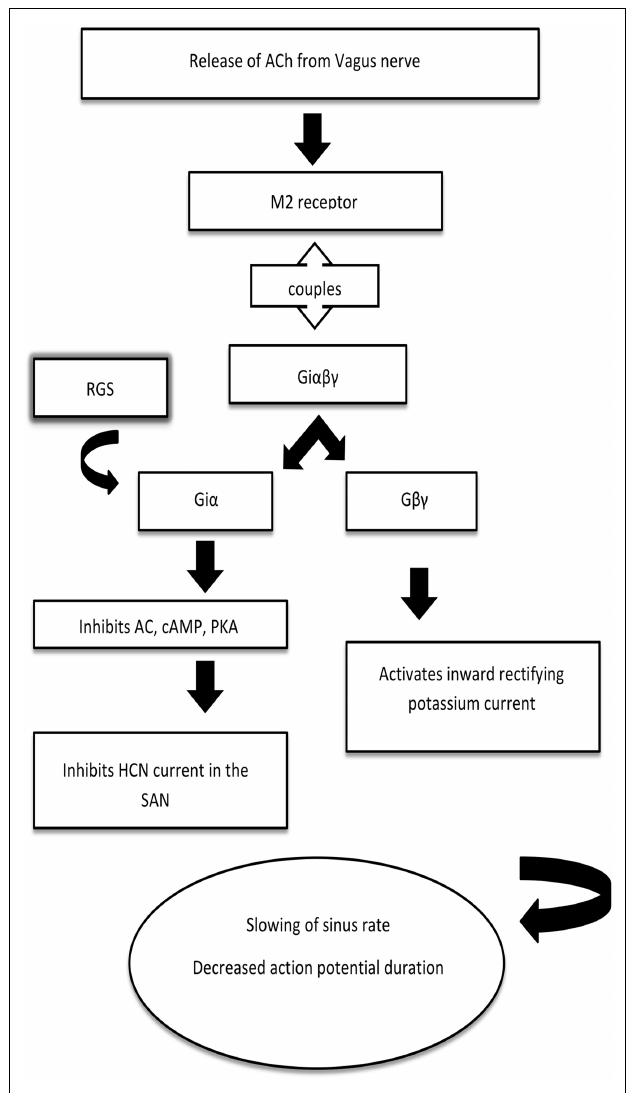
FIGURE 1 |A simplified schematic for the mechanism of heart rate regulation by inhibitory G proteins. Acetylcholine released from the vagus nerve binds to the muscarinic (M2) receptor, which is coupled to the inhibitory G protein.The βγ -dimer activates the G protein coupled inward rectifying potassium (GIRK) channel to slow the sinus rate, decrease the action potential duration and allow arrhythmia generation. Regulators of G protein signaling (RGS) interact with the α -subunit to switch off this pathway through GTPase accelerating protein activity and allow the heterotrimer to reform. AC, adenylyl cyclase; cAMP, cyclic AMP; PKA, protein kinase A; HCN, hyperpolarization-activated cyclic nucleotide-gated